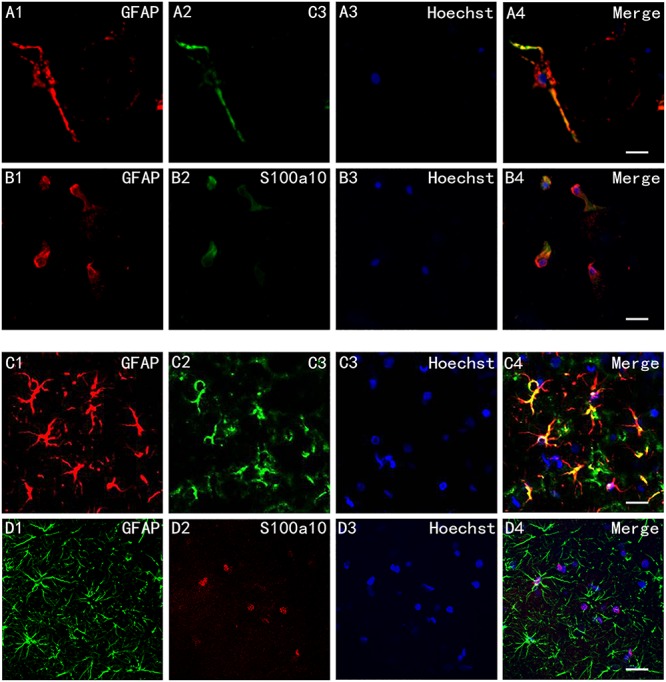
Cell morphology of A1 and A2 astrocytes in vitro and in vivo. (A1–A4) Immunofluorescence staining of cultured astrocytes in vitro after exposure to infrasound for 2 h with glial fibrillary acidic protein (GFAP) and component 3 (C3), and (B1–B4) with GFAP and S100a10. (C1–C4) Immunofluorescence staining of astrocytes in the CA1 region in rats after exposure to infrasound for 3 days with GFAP and C3, and (D1–D4) with GFAP and S100a10. Nuclei stained with Hoechst. Scale bar: 25 μm.